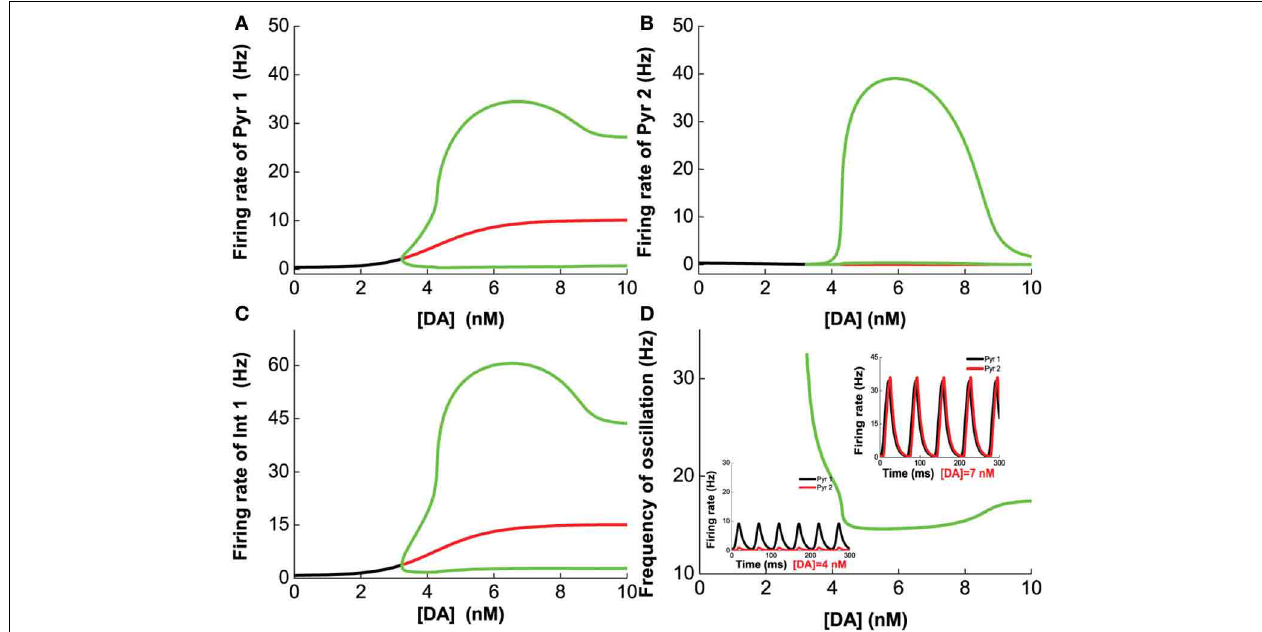
suppress it (B) . (D) The frequency of the oscillation decreases with increasing [DA] due to the D1 receptors before it increases slightly again